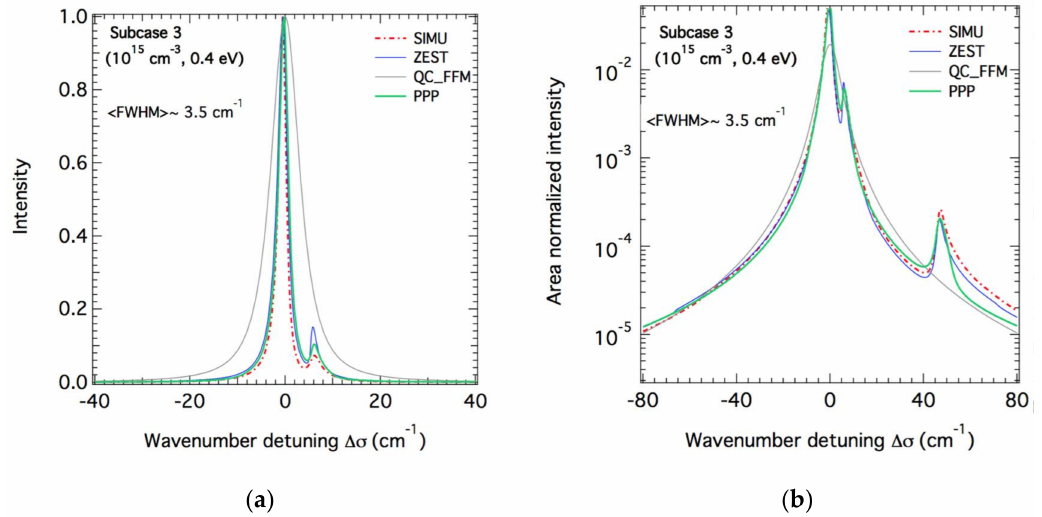
Figure 3. Same as Figures 1 and 2 but for T e = T i = 0.4